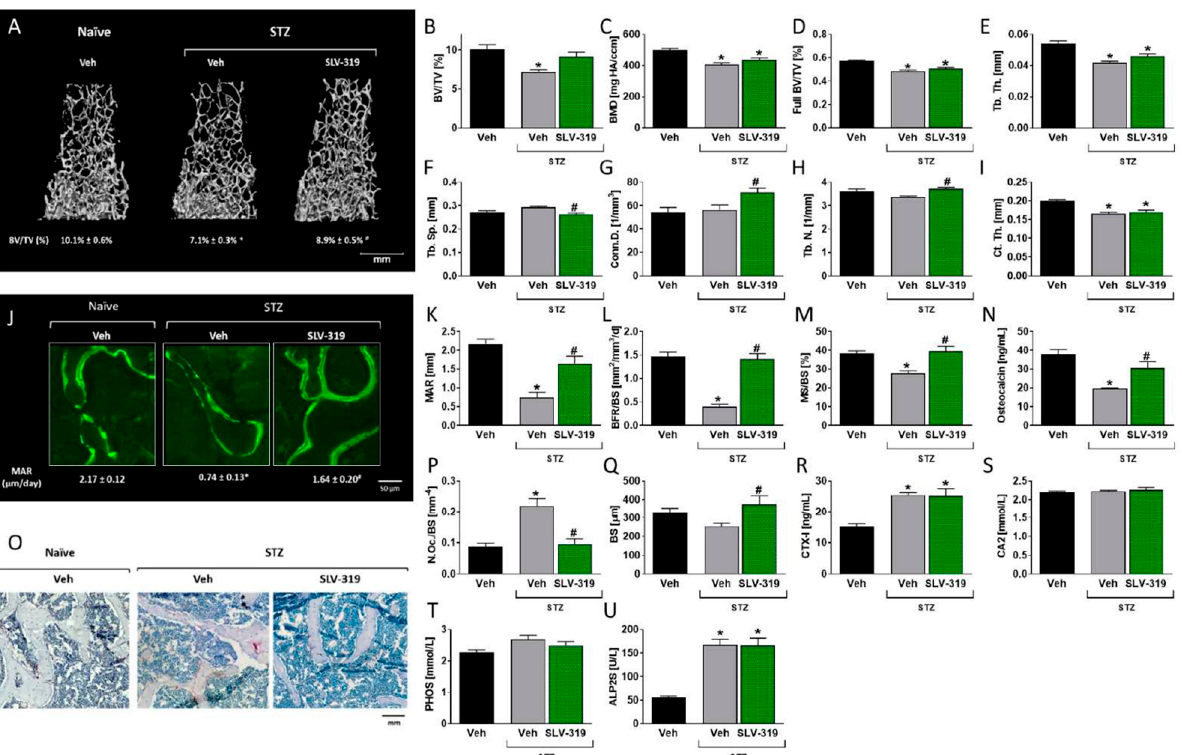
Figure 4. Chronic CB 1 R blockade prevents T1D-induced bone loss. 3D representative images of the distal femoral metaphysis of mice with median bone volume density (BV/TV) values ( A , B ). Bone mineral density (BMD; C ), full bone BV/TV ( D ), trabecular thickness (Tb.Th; E ), trabecular spacing (Tb.Sp.; F ), connectivity density (Conn.D; G ), trabecular number (Tb.N; H ), and cortical thickness (Ct.Th; I ). Histomorphometric and biochemical analysis of bone remodeling parameters reveals a rescue of diabetes-induced bone loss by SLV-319. Representative images of calcein-labeled mineralized fronts ( J ), the mineral apposition rate (MAR; K ), the bone formation rate (BFR/BS; L ), the mineralizing surface ( M ), and the serum osteocalcin levels ( N ). Images of TRAP+ osteoclasts ( O ) show the number of osteoclasts per trabecular surface area (N.Oc/BS; P ), the bone surface (BS; Q ), and the serum levels of CTX-1 ( R ), as well as the levels of biochemical markers, calcium (CA2; S ), phosphate (PHOS; T ), and alkaline phosphatase (ALP2S; U ). Data represent the mean ± SEM from 8–10 mice per group, * p < 0.05 relative to the corresponding control group treated with Veh, # p < 0.05 relative to the corresponding streptozotocin (STZ) group treated with Veh.